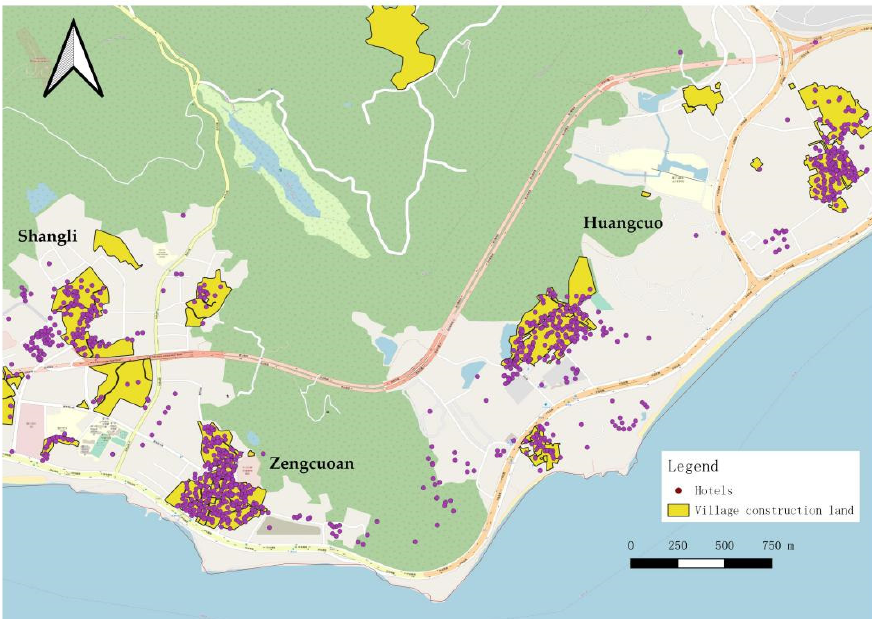
Figure 5. Spatial layout of villages by the sea on Xiamen Island. Source: drawn by the authors. The base map is obtained from the Openstreet map.